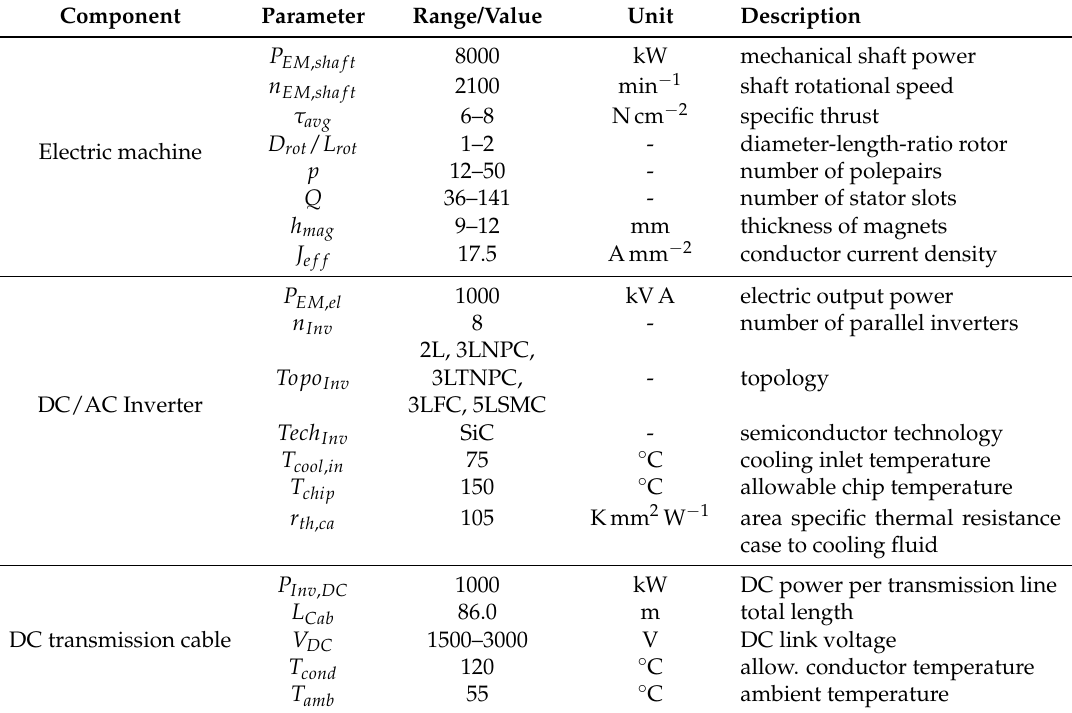
Table 1. Global requirements and input ranges for global and local variation